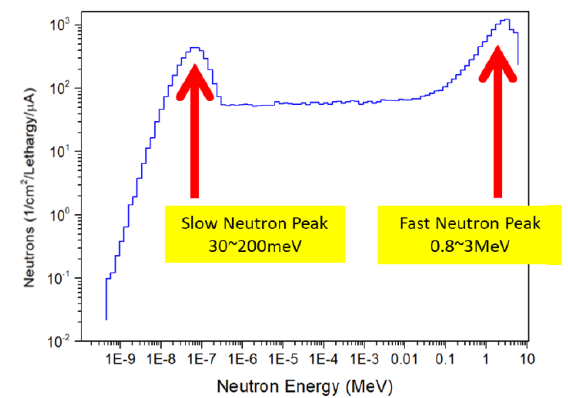
Fig. 2. RANS neutron spectrum at 3 m away from the target by PHITS simulation.